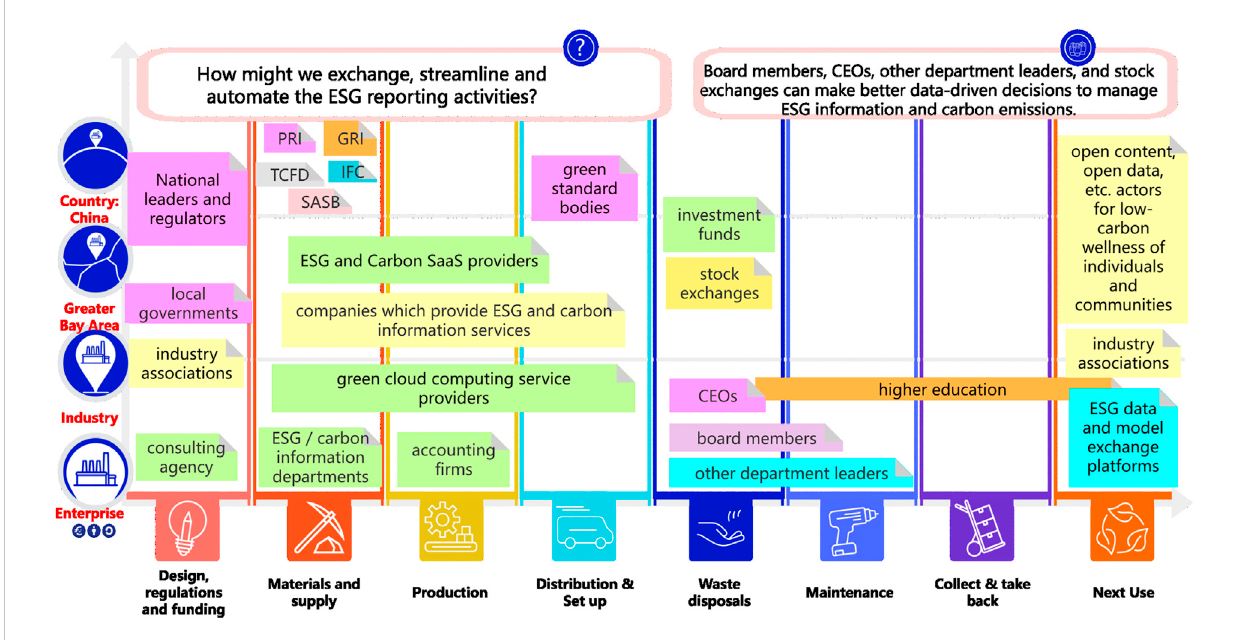
FIGURE 2 Partner map for ESG reporting (based on the blank canvas provided by Circulab (2020) through Creative Commons License Attribution- NonCommercial-ShareAlike 4.0